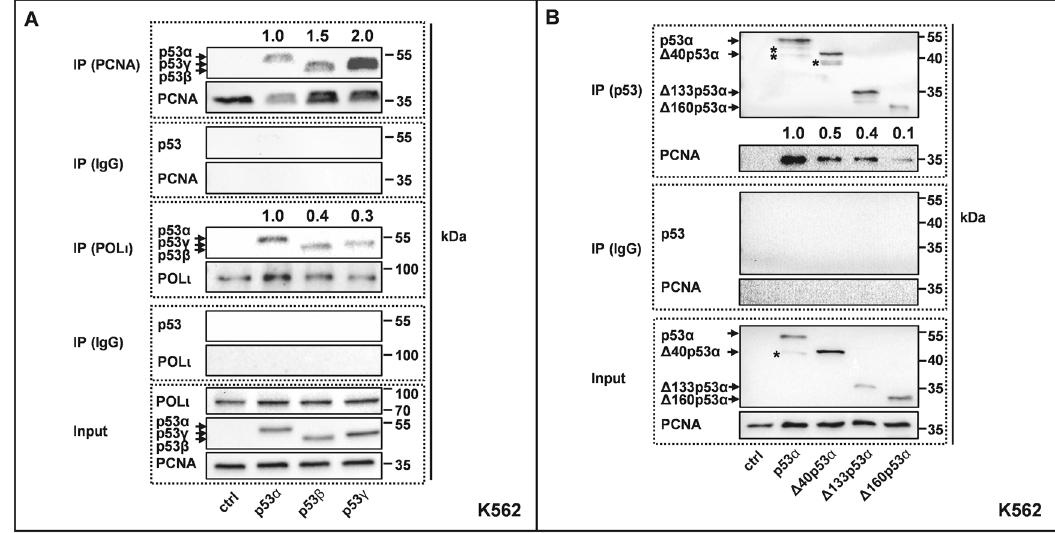
Fig. 4 p53 isoforms differently interact with PCNA and POL ι . K562 cells were transfected with expression plasmids for p53 α , alternative p53 isoforms [ A p53 β , p53 γ , B Δ 40p53 α , Δ 133p53 α , Δ 160p53 α ] or EV in controls (ctrl). Forty-eight hours after transfection, cells were harvested for immunoprecipitations (IP) after preparation of crosslinked chromatin ( A ) or without crosslinked chromatin preparation ( B ). For the pull-downs of PCNA ( A ) anti-PCNA antibody (mouse, ab29, abcam, Cambridge, UK) or control Mouse IgG (Santa Cruz, Dallas, Texas, USA), for the pull- downs of POL ι ( A ) POL ι -antibody (rabbit, A301-304A, Bethyl, Montgomery, USA) or Rabbit IgG were used. For the pull-down of p53 ( B ) a mix of anti-p53(DO11) (mouse, MCA1704, BioRad Laboratories, München, Germany) and anti-p53(Pab421) (mouse, OP03, Calbiochem, Darmstadt, Germany) or control Mouse IgG were used. Subsequent immunoblotting relied on anti-POL ι (rabbit, A301-304A, Bethyl, Montgomery, USA), anti-p53(DO1) (mouse, mAb, 554293, BD, Biosciences, Franklin Lakes, New Jersey, USA) in ( A ), anti-p53(DO11) (mouse, GTX75258, Genetex, Irvine California, USA), anti-p53 (PAb421, rabbit, ab245685, Abcam Cambridge, UK), anti-PCNA (mouse, ab29, abcam, Cambridge, UK) in ( B ) and light chain-speci fi c peroxidase-coupled secondary antibody. *, asterisks mark bands possibly stemming from proteolytic cleavage of the p53- isoform. Quanti fi cation of band intensities of co-precipitated proteins relative to their input is indicated. Representative Western blots from three to four experiments are